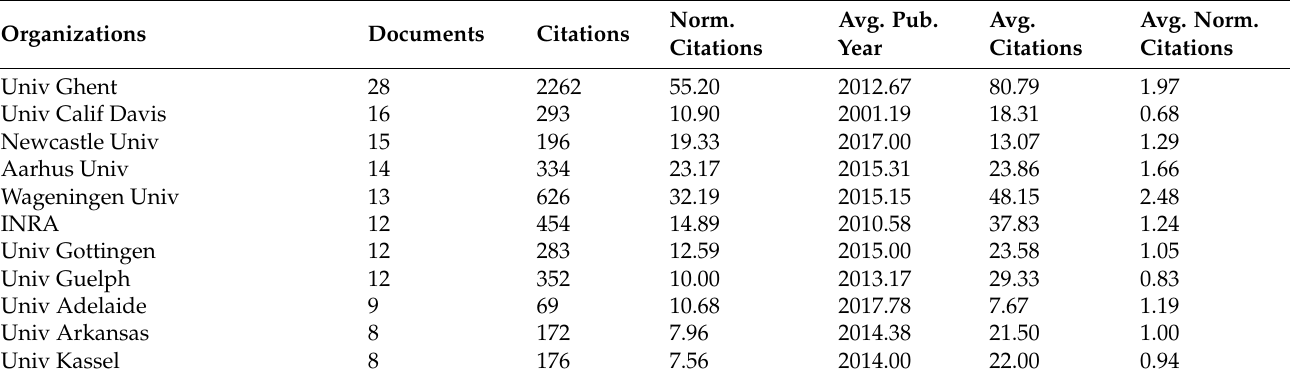
Table A4. Bibliometric information for the organizations which have more documents (top